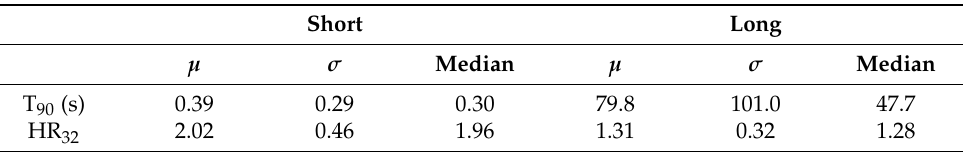
Figure 4. Violin plots showing the distribution of the duration (T 90 ) and hardness ratio (HR 32 ) for the Swift /BAT ‘short’ (red) and ‘long’ (blue) classes identified by clustCombi . The median of each parameter is marked as a black line within the box, which represents the 1 σ interval (i.e., the 16th to 84th percentile). Table 3. Mean ( µ ), standard deviation ( σ ), and median of the properties of the Swift /BAT ‘long’ and ‘short’ classes identified by clustCombi